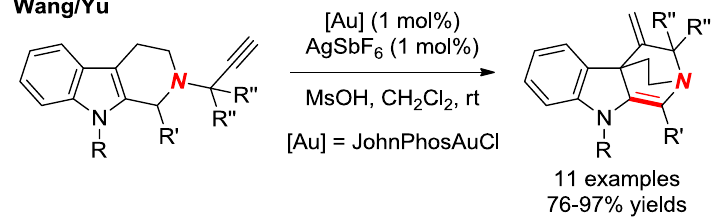
Figure 22. Synthesis of Bridged Enamines via Gold-Catalyzed Spriocyclization.